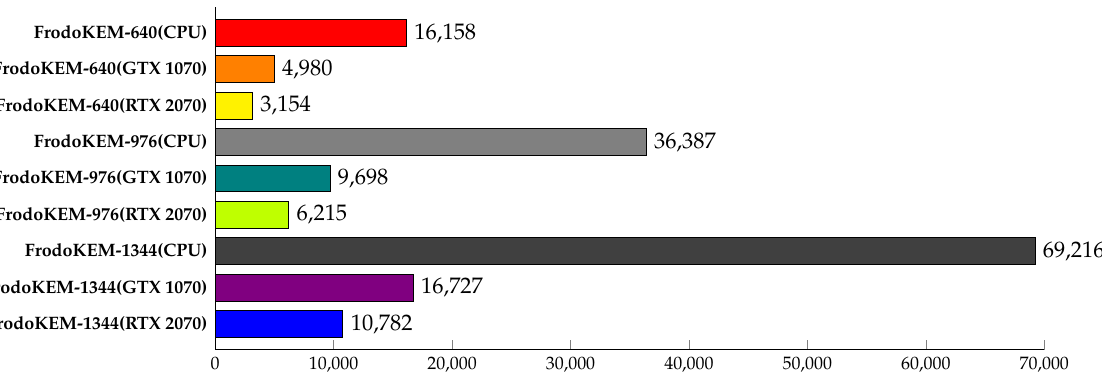
Figure 8. Comparison of operation time ( µ s) for FrodoPKE encryption between CPU implementation and GPU implementation including memory copy